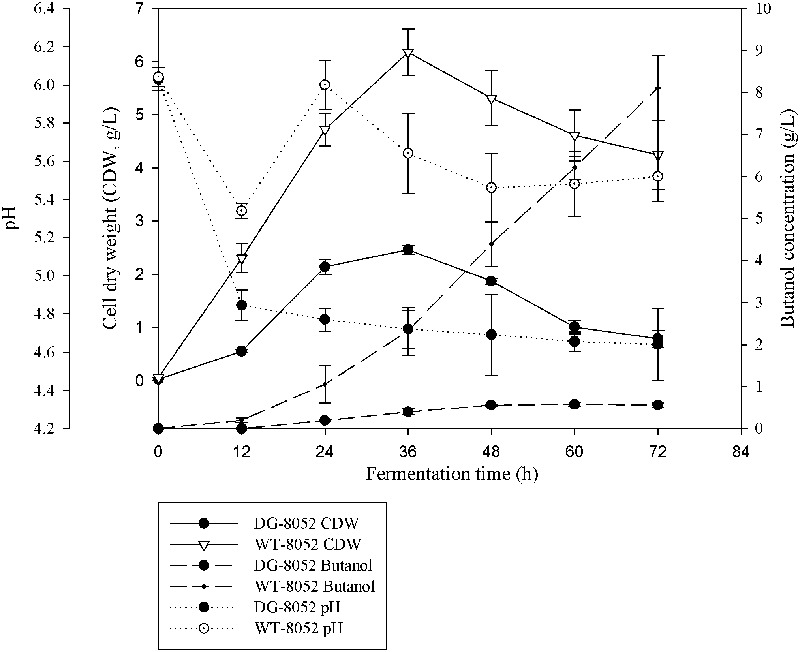
Fermentation profiles for C. beijerinckii NCIMB 8052 and its degenerate stain DG-8052 in P2 medium.